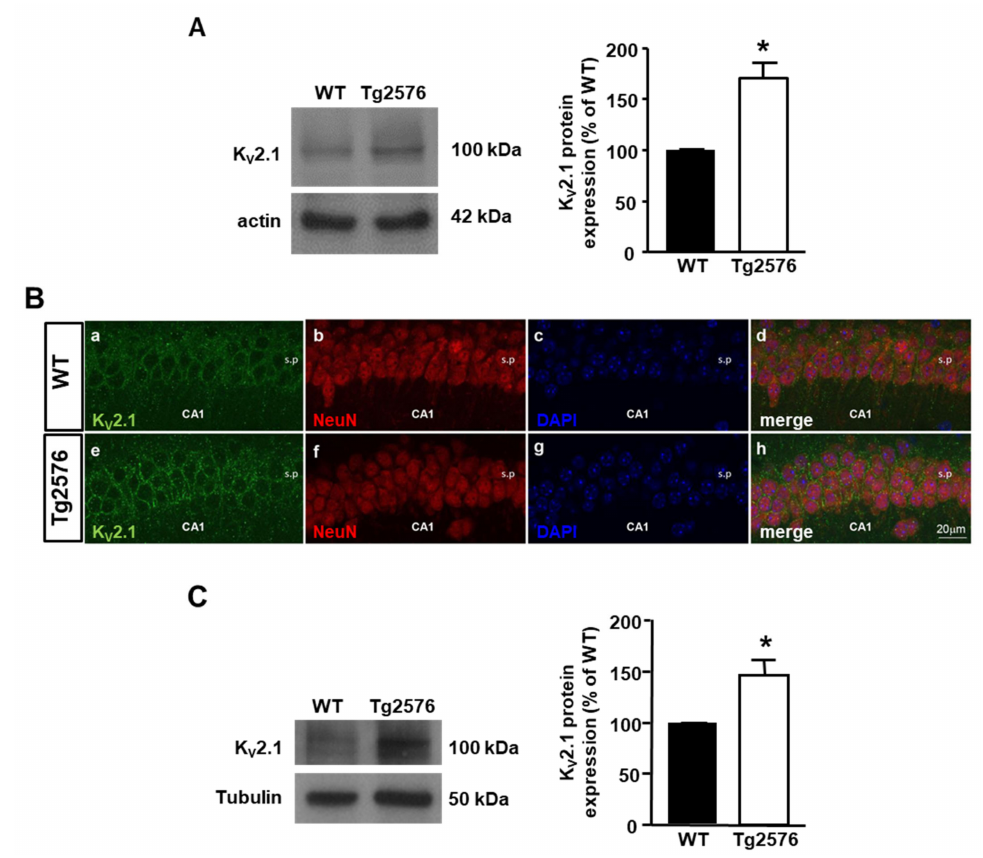
Figure 1. K V 2.1 protein expression in the hippocampus of 3-month-old Tg2576 mice and in Tg2576 primary hippocampal neurons. ( A ) Representative Western blotting ( left ) and densitometric quan- tification ( right ) of K V 2.1 protein expression in the hippocampus of 3-month-old WT and Tg2576